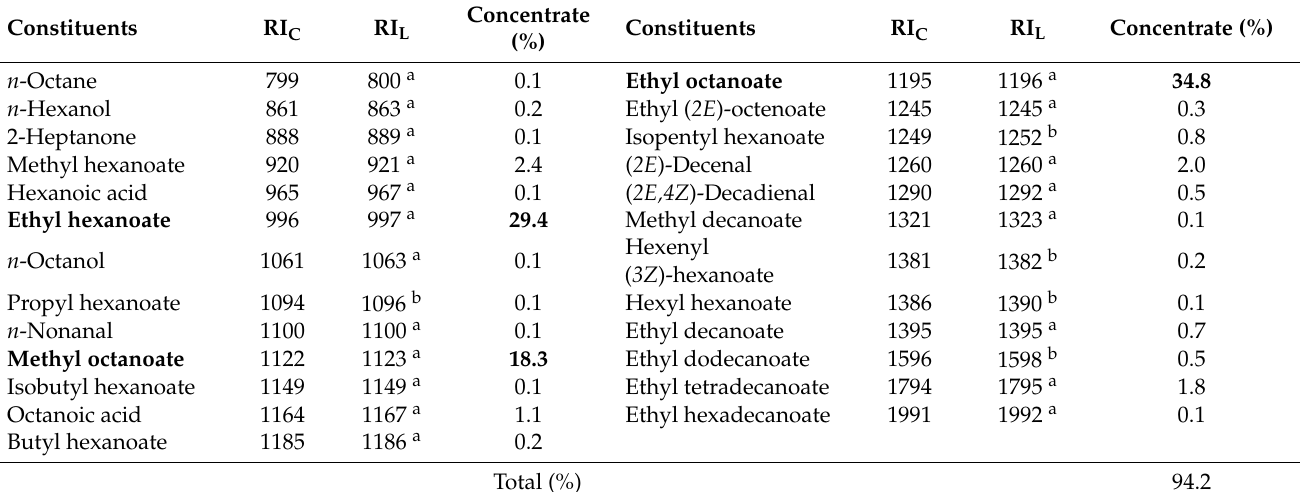
Table 2. Constituents of volatile concentrate of lyophilized fruit pulp of Annona crassiflora